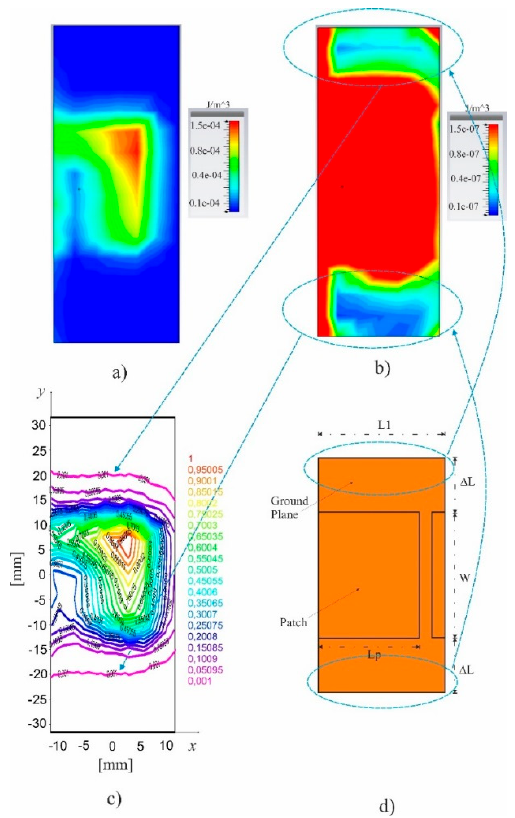
Figure 13. ( a ) Electric energy density on the ground plane for the antenna with Δ L = 20 mm. ( b ) Electric energy density on the ground plane for the antenna with Δ L = 20 mm with the maximum peak set to a value 10 3 times lower than the one shown in (a). ( c ) Normalized electric energy density on the ground plane for the antenna with Δ L = 20 mm represented with contour lines. ( d ) Profile of the extended ground plane following the electric energy density shown in (b), with Δ L = 12.5 mm.